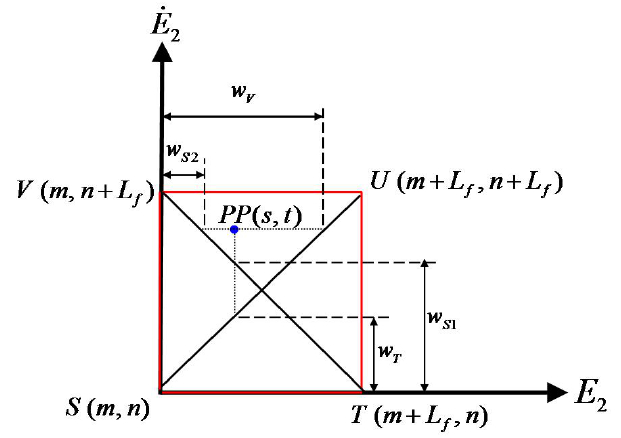
Figure 8. Membership functions for decision of output rules.